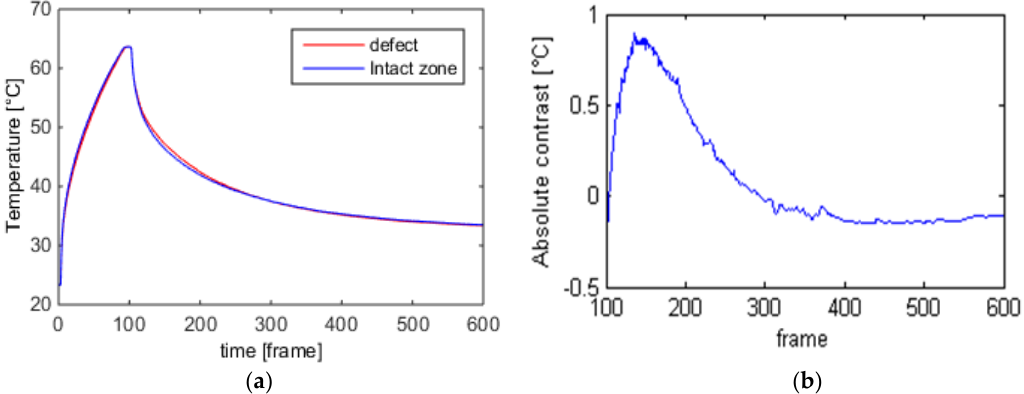
Figure 9. ( a ) Thermal profiles and ( b ) absolute contrast example for defect-2 (Ø 10 mm) and intact area in Plate I, using heating time of 20 s.